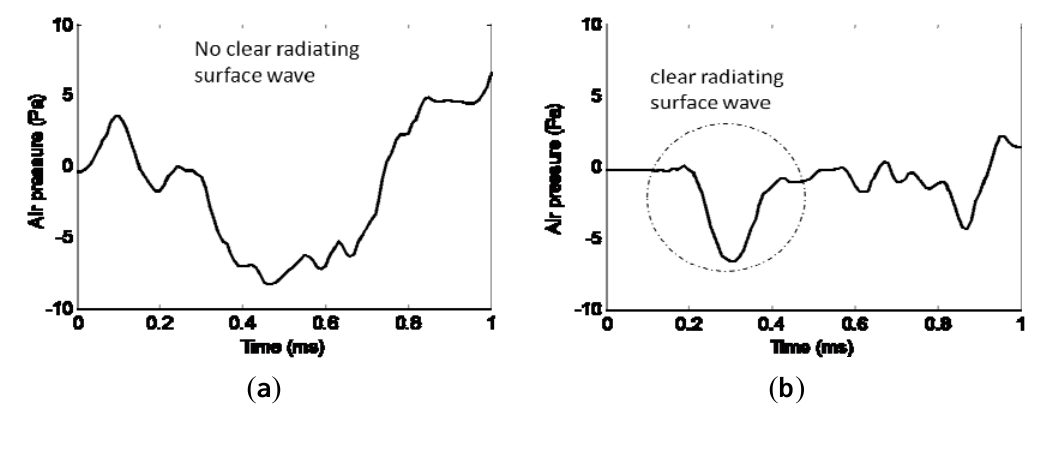
Figure 6. Effects of the sound enclosure for microphone in noisy environment. ( a ) Without enclosure. ( b ) With